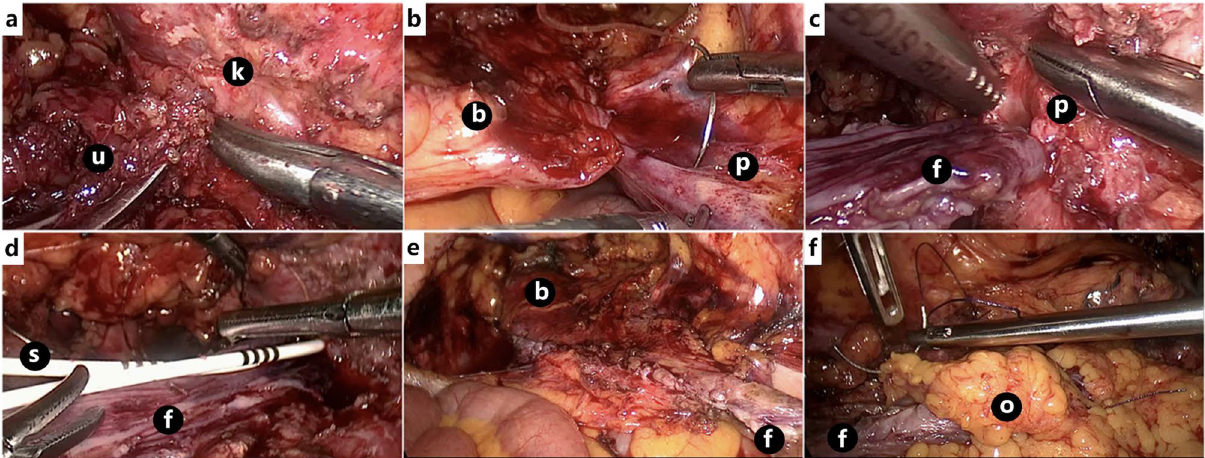
Figure 1. ( a ) separate renal pelvis, upper ureter; (k: kidney; u: ureteral stump), ( b ) psoas major suspension; (b: bladder; p: psoas major), ( c ) inverted bladder flap; (p: pelvis; f: flap), ( d ) double J tube inserted; (s: ureteral stent; f: flap), ( e ) valve tube formation; (b: bladder; f: formation ureter), ( f ) pedicled omentum isolated coverage; (o: great omentum; f: formation